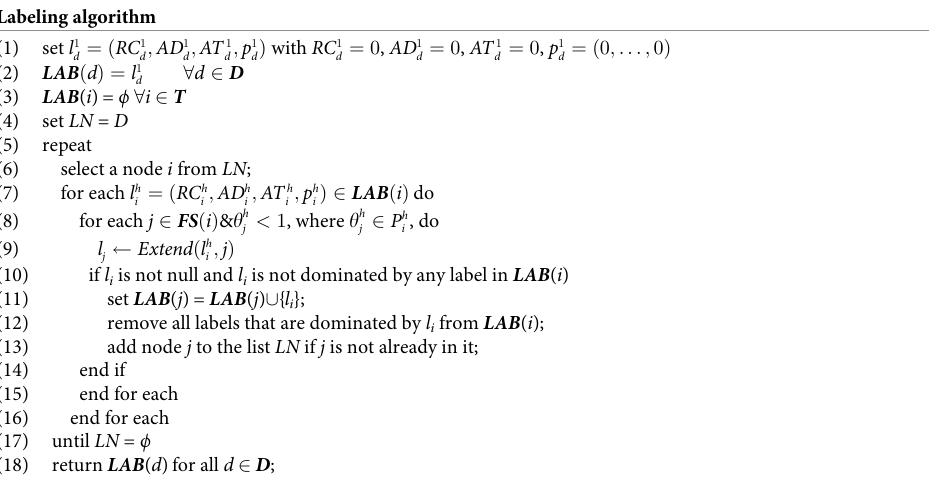
Table 5. Dynamic programming labeling algorithm. Labeling